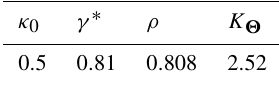
Figure 10. Stress variation for compliant link (link 4) with respect to crank (link 2)